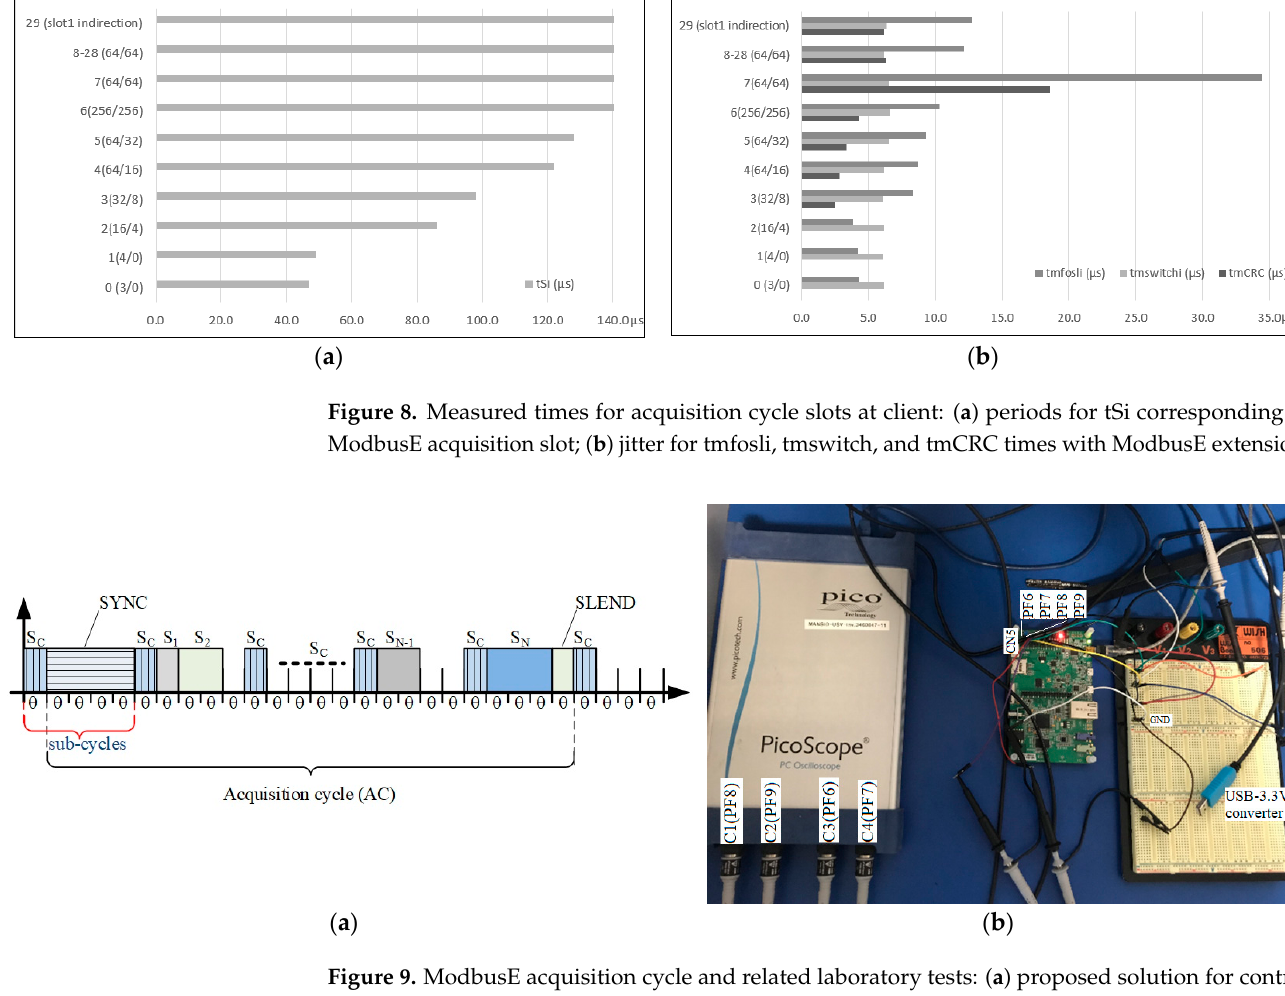
Figure 8. Measured times for acquisition cycle slots at client: ( a ) periods for tSi corresponding to ModbusE acquisition slot; ( b ) jitter for tmfosli, tmswitch, and tmCRC times with ModbusE extension.